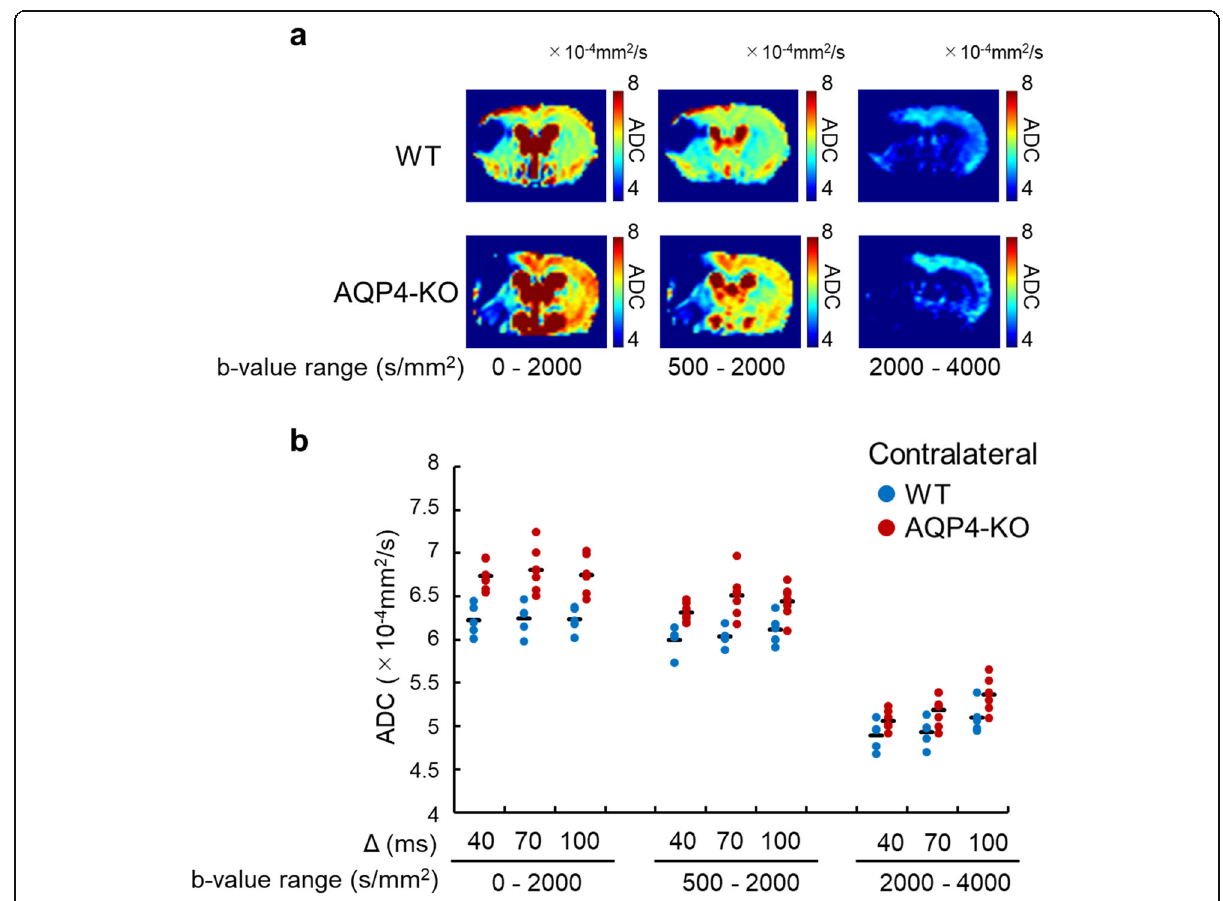
Fig. 3 Apparent diffusion coefficient (ADC) in the contralateral region. Typical ADC maps of wild-type (WT) and aquaporin-4 knockout (AQP4-KO) mice (top and bottom, respectively), focused on the contralateral region ( a ). The ADC in the contralateral region has a range of 4 – 8 × 10 − 4 mm 2 /s. The plots show the mean ADC of each WT (blue) and AQP4-KO (red) mouse for each b -value range and Δ ( b ). The black bars correspond to the mean over animals. The results of the statistical analysis are shown in Table 2. The ADC maps and bar graphs for b = 4,000 – 6,000, and 6,000 – 8,000 s/mm 2 are excluded because of low signal-to-noise ratio (see Fig.